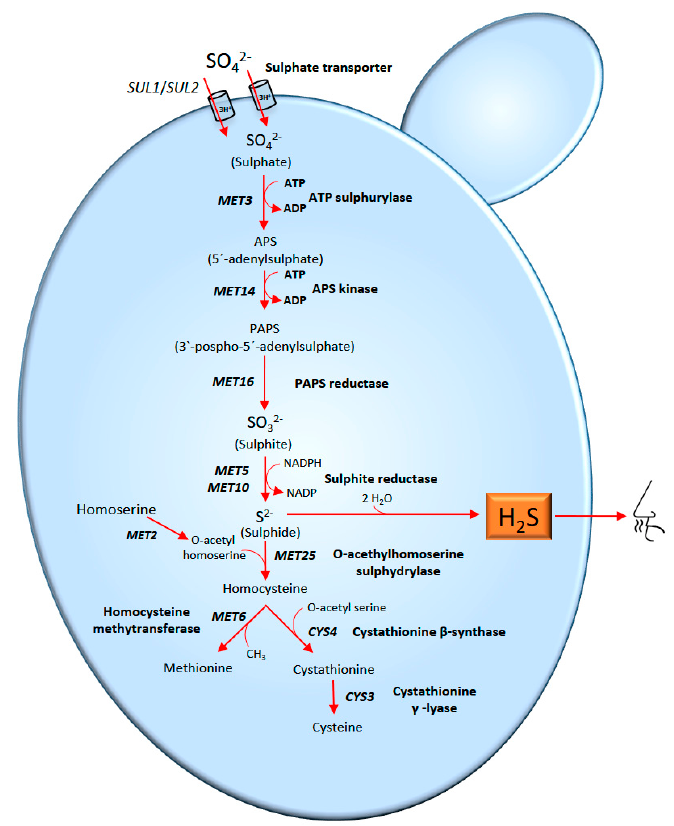
Figure 4. The first step of the pathway consists of the sulphate uptake through two specific permeases in co-transport with 3H + . Then, sulphate is reduced to sulphide in several steps using the enzymes ATP sulphurylase and sulphite reductase. The sulphide afterwards combines with O -acetylserine to